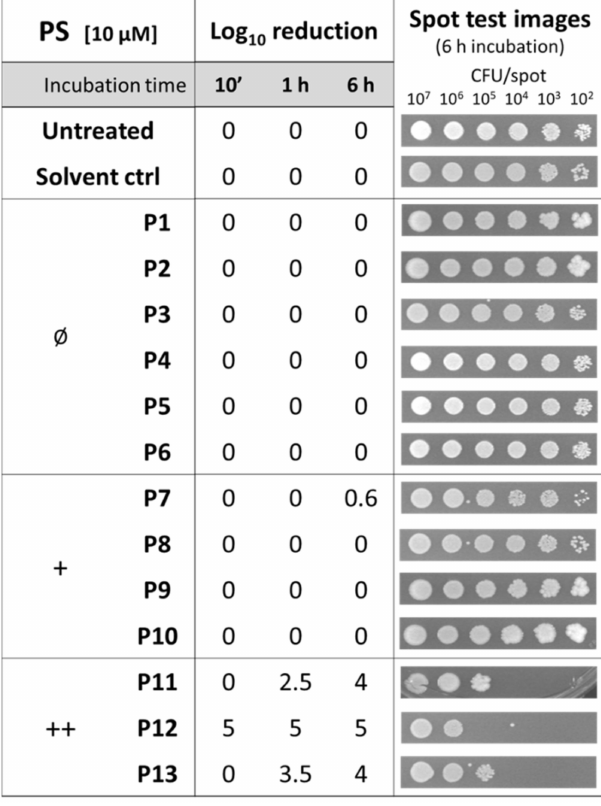
Figure 1. Analysis of intrinsic toxicity of diaryl-porphyrins ( P1 – P13 ) administered at a concentration of 10 µ M to Staphylococcus aureus ATCC 6538P for 10 min, 1 h, and 6 h of dark incubation. Untreated and DMSO-treated samples (“Solvent ctrl”) were included as controls. Log 10 reduction values represent the mean of at least three independent experiments. Representative images reported in the last column refer to growth spots at decreasing bacterial densities (from 10 7 to 10 2 CFU/spot) upon 6h of dark incubation with the corresponding